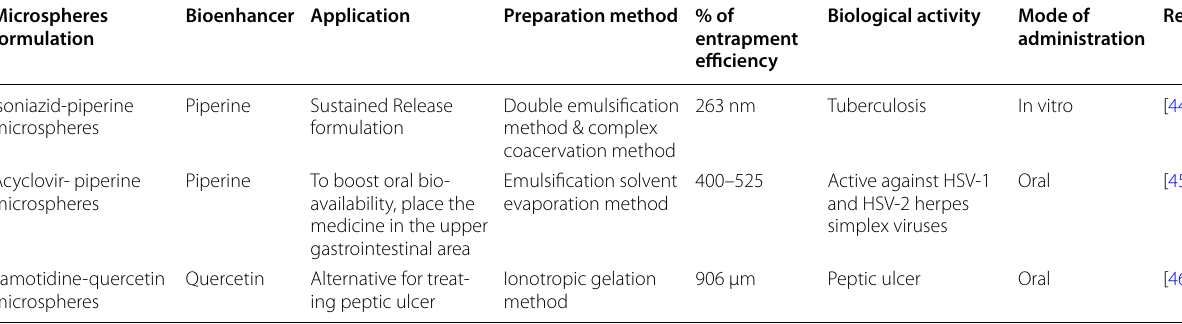
Table 5 Microspheres formulation containing natural bioenhancer Microspheres